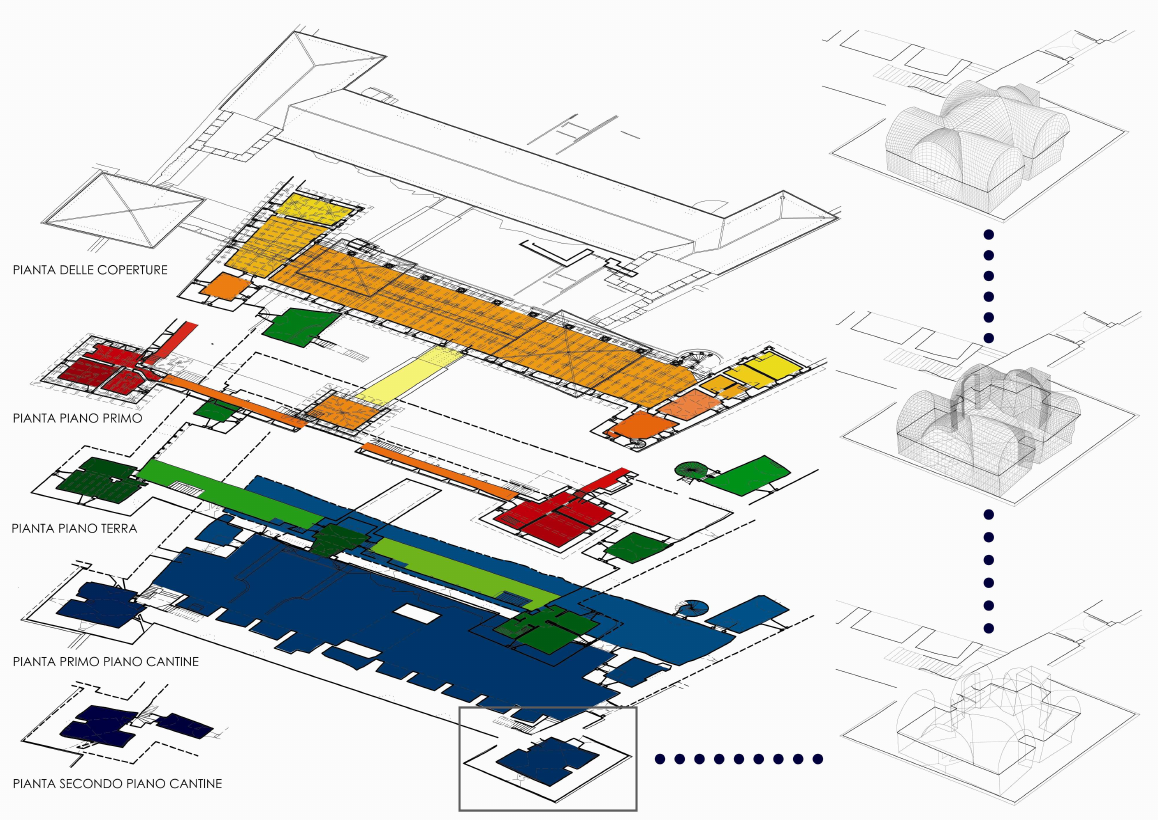
Figure 3. Layout of the interactive digital map for the virtual museum